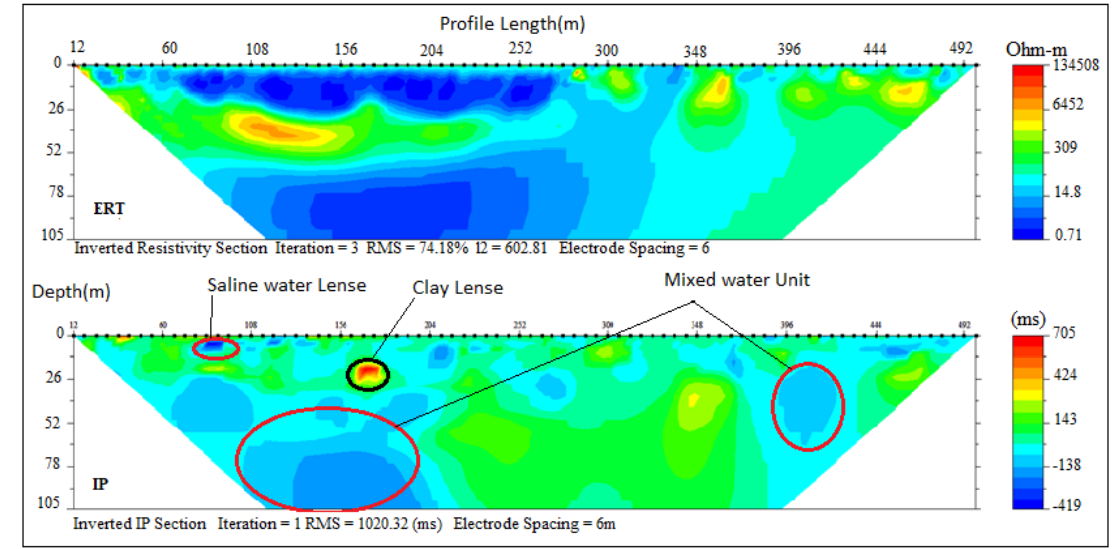
Figure 4. Inverted resistivity and induced polarisation (IP) cross-sections Ugbonla (Profile section P1). Table 4. Lithological interpretation of geoelectrical sections from Profile A – B.